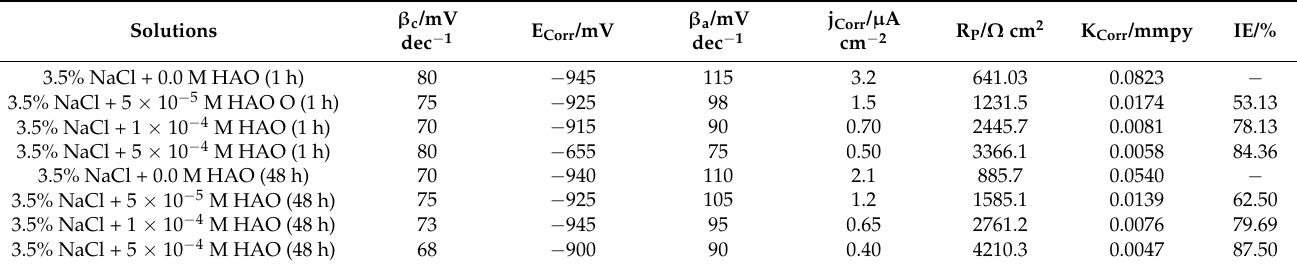
Table 2. The data obtained from the polarization